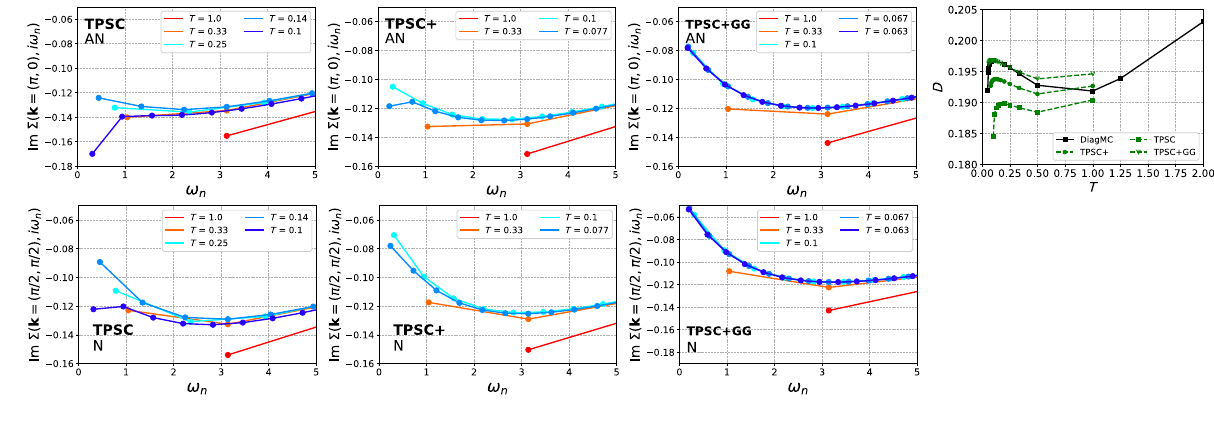
FIG. 38. Results from TPSC, TPSC+, and TPSC þ GG.